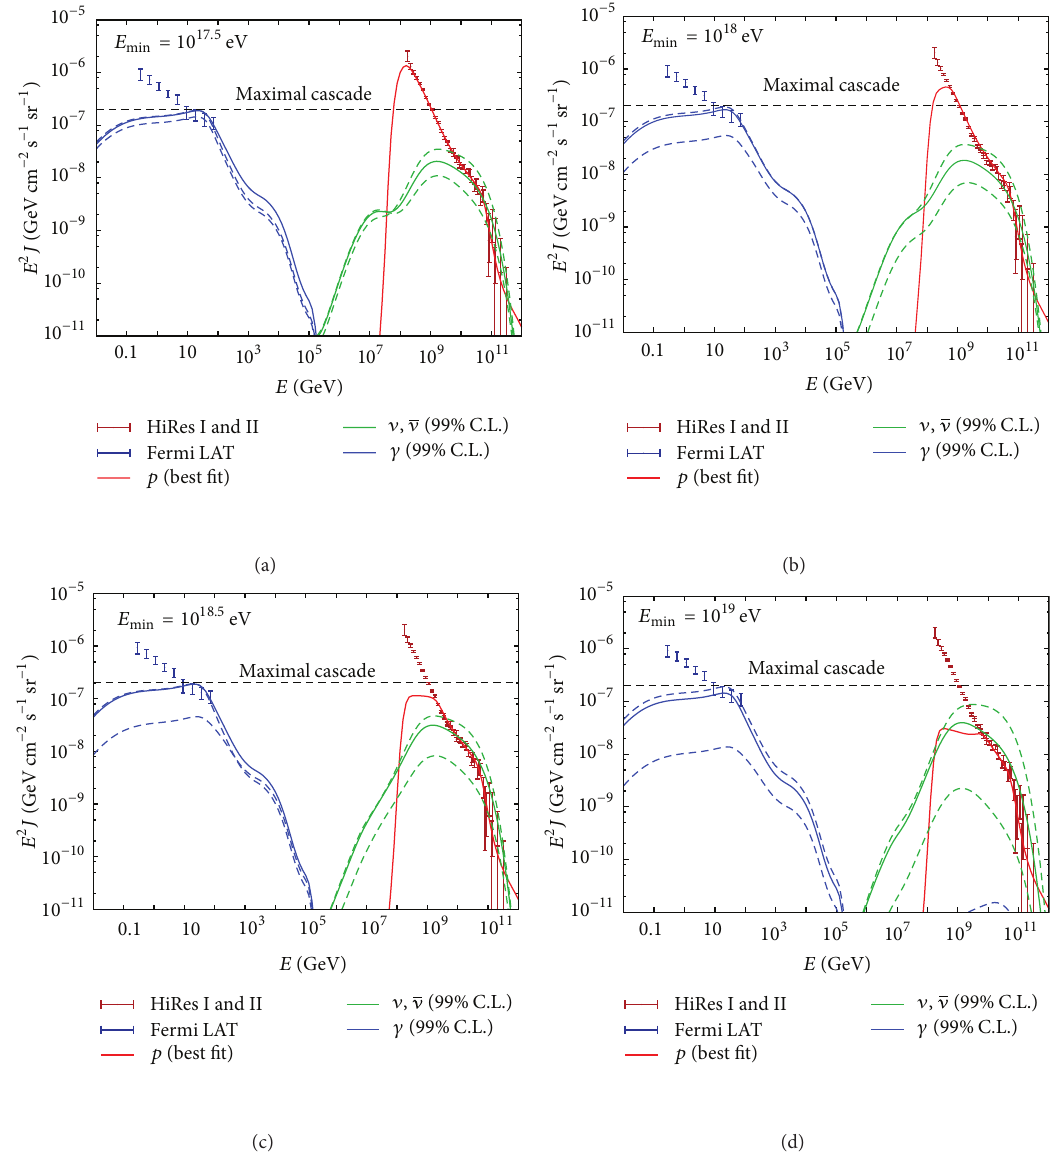
Figure 6: Comparison of proton, neutrino, and gamma-ray fluxes produced in interactions on the CMB by cosmic-ray protons fitted to HiRes data. We repeat the calculation for 4 values of the crossover energy marking the transition to the extragalactic cosmic-ray flux. We show the best fit values (solid lines) as well as neutrino and gamma-ray fluxes within the 99% C.L. with minimal and maximal energy density (dashed lines). The 𝛾 -ray fluxes are marginally consistent at the 99% C.L. with the highest energy measurements by Fermi-LAT. The contribution around 100 GeV is somewhat uncertain, due to uncertainties in the cosmic infrared